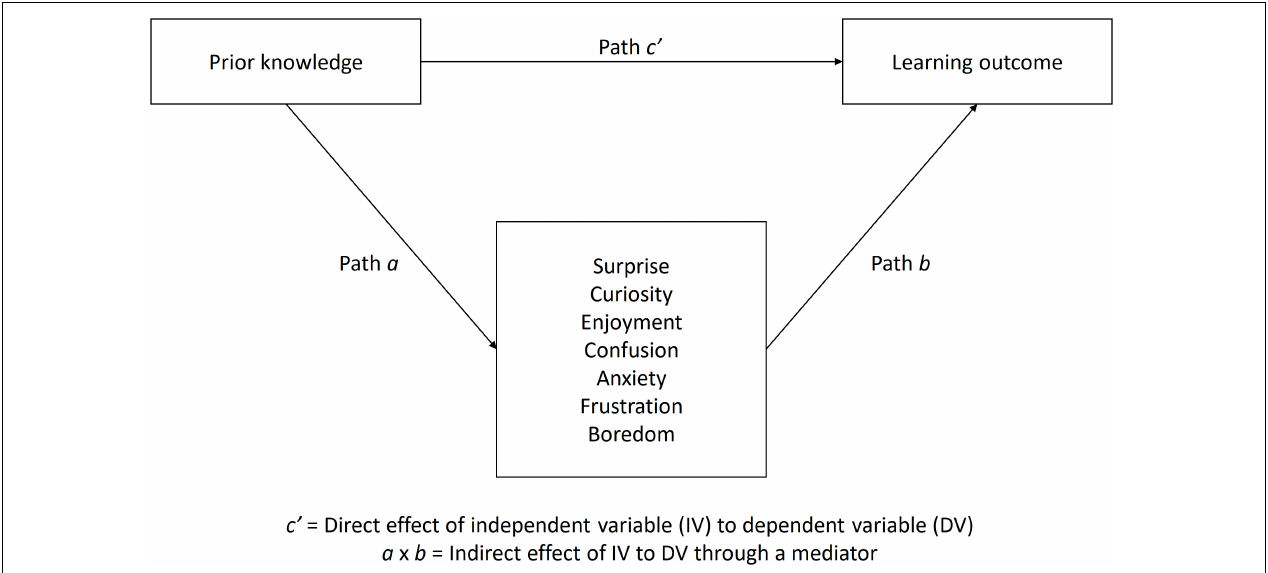
FIGURE 1 | A conceptual model in which the effect of the prior knowledge on the learning outcome is mediated by situational epistemic emotions.